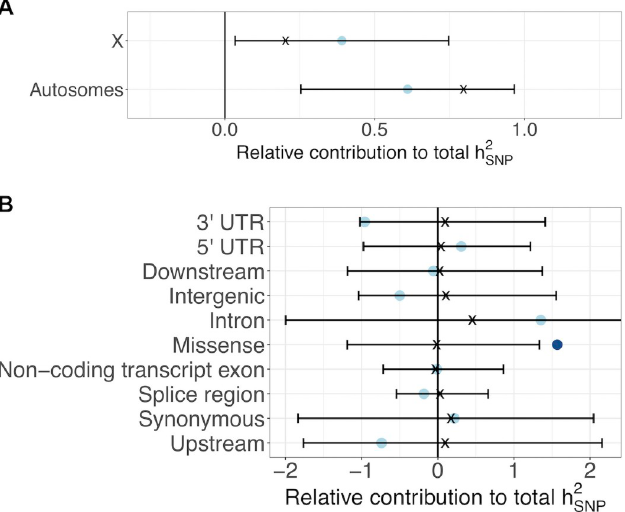
Fig 2. Genomic distribution and functional characteristics of antagonistic variants. (A) Relative contribution of different chromosomal compartments to total SNP heritability of the antagonistic index (i.e., h 2 estimated for a given SNP compartment divided by total h 2 across all compartments). Dots represent estimated h 2 contributions ( ± 95% CI), SNP SNP with expected h 2 contributions presented as black crosses. (B) Relative contribution of different functional categories SNP to total antagonistic h 2 (i.e., h 2 estimated for a given functional category divided by total h 2 across all categories). SNP SNP SNP Dots represent estimated h 2 contributions, with expected h 2 contributions presented as black crosses ( ± 95% CI of SNP SNP the empirical null distribution computed through permutation; see Materials and methods). Colours indicate significant under- or overrepresentation (dark blue: P < 0.05; light blue: P > 0.05). Data and code underlying this figure can be found at https://doi.org/10.5281/zenodo.2623225. SNP, single nucleotide polymorphism; UTR, untranslated